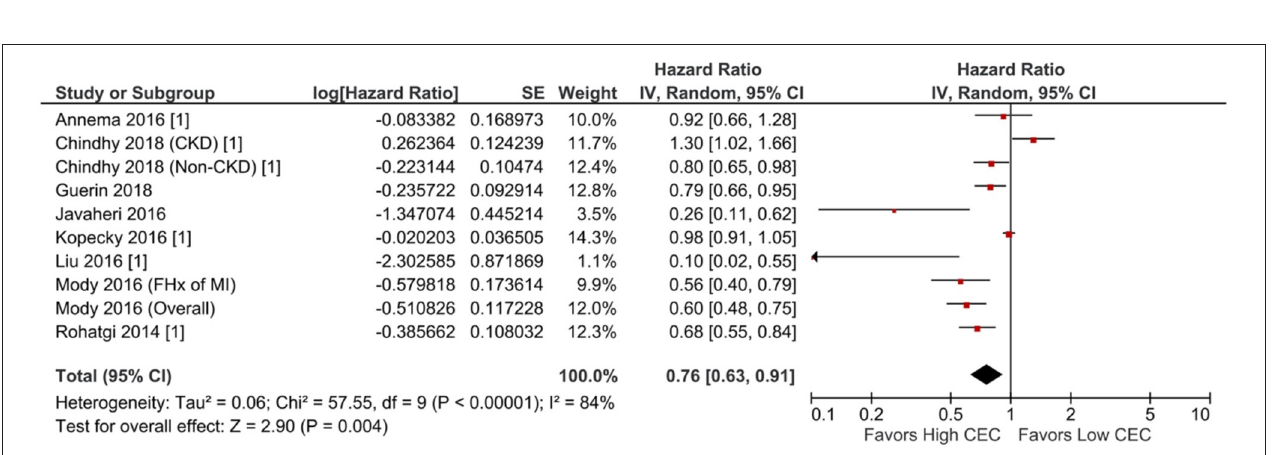
FIGURE 3 | Adverse cardiovascular event: Per SD increment of CEC (adjusted HR) (10 studies). CEC, cholesterol efflux capacity; CI, confidence interval; CKD, chronic kidney disease; df, degree of freedom; FHx, family history; HR, hazard ratio; IV, inverse variance; MI, myocardial infarction; SE, standard error.